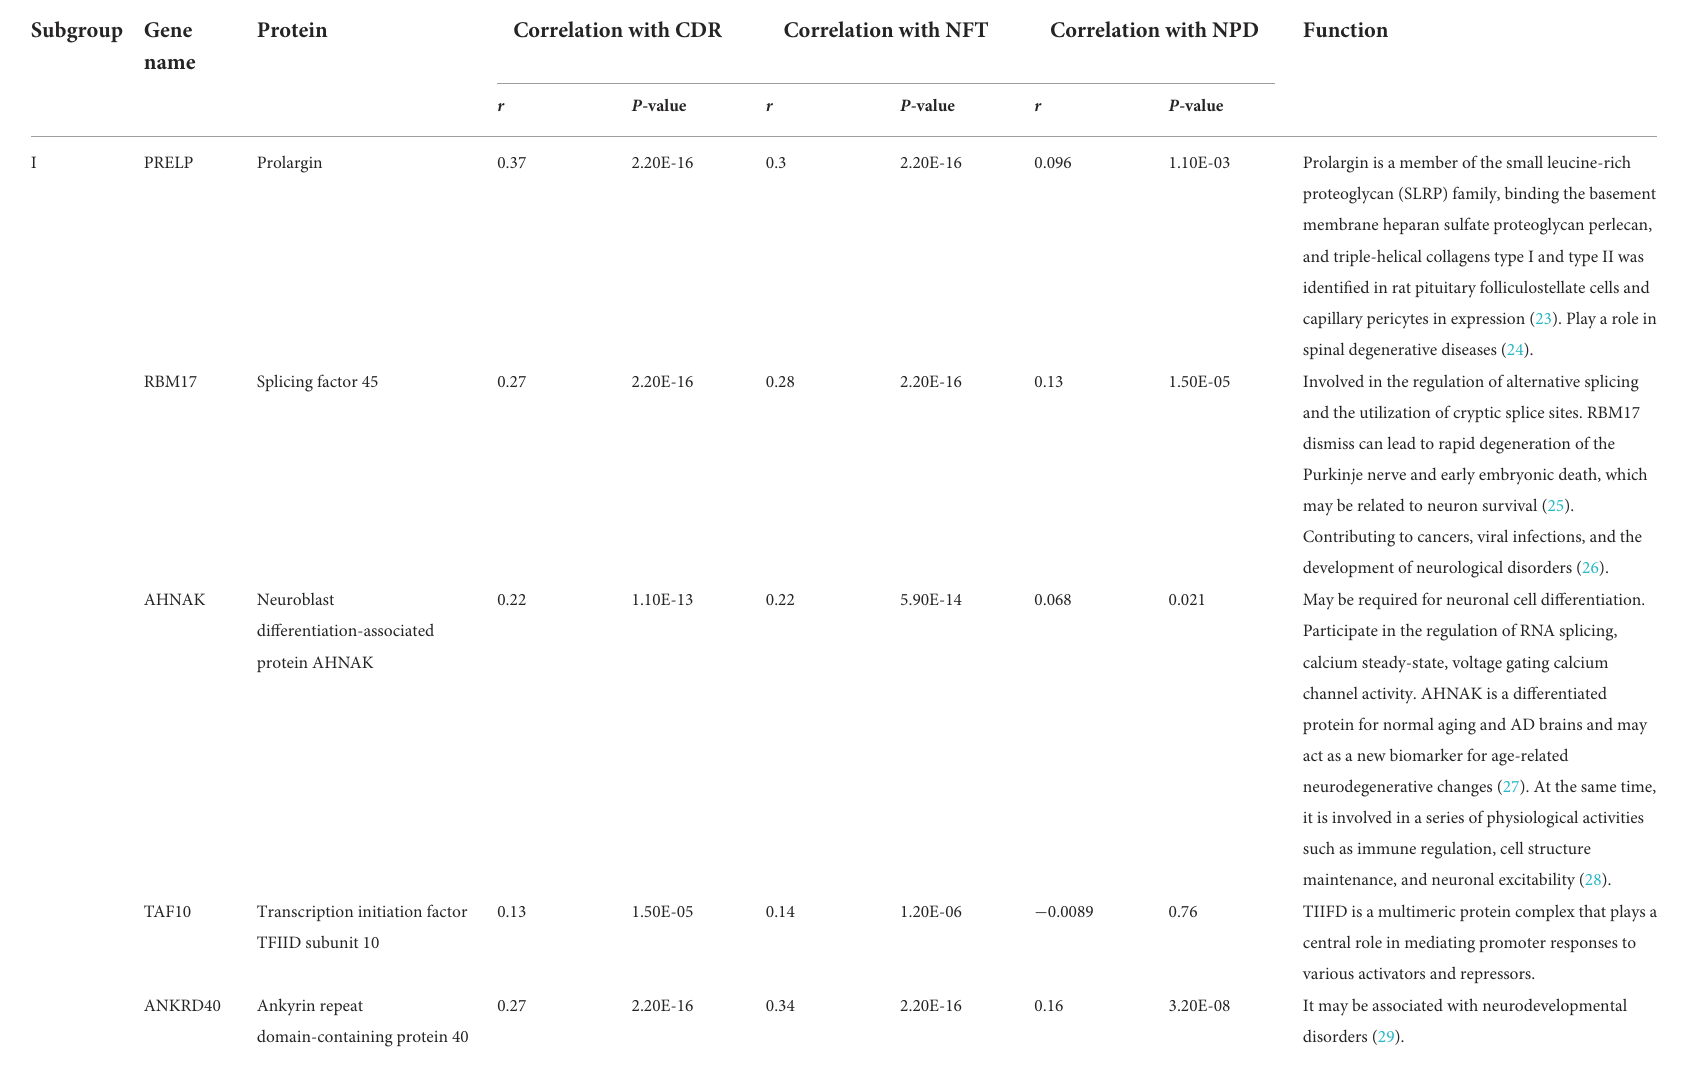
TABLE 1 Functional annotation of hub